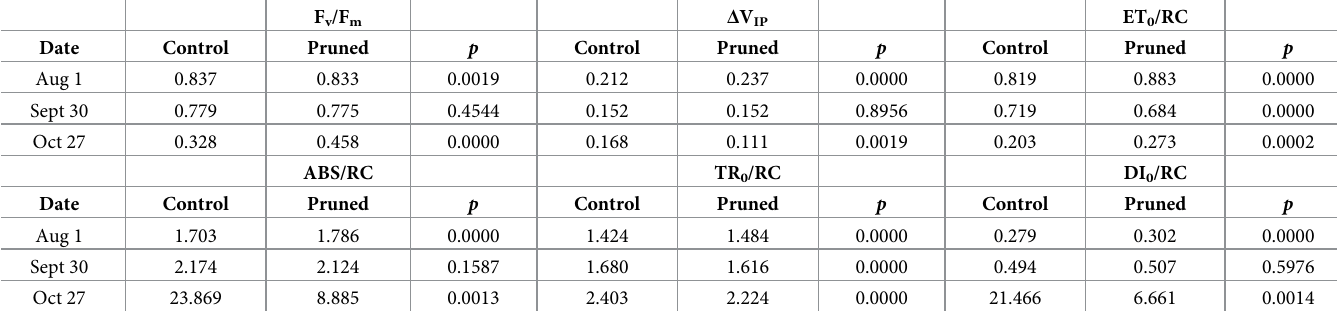
Table 2. Chlorophyll fluorescence parameters in undamaged (control) and severely pruned trees recorded in the first season after pruning.